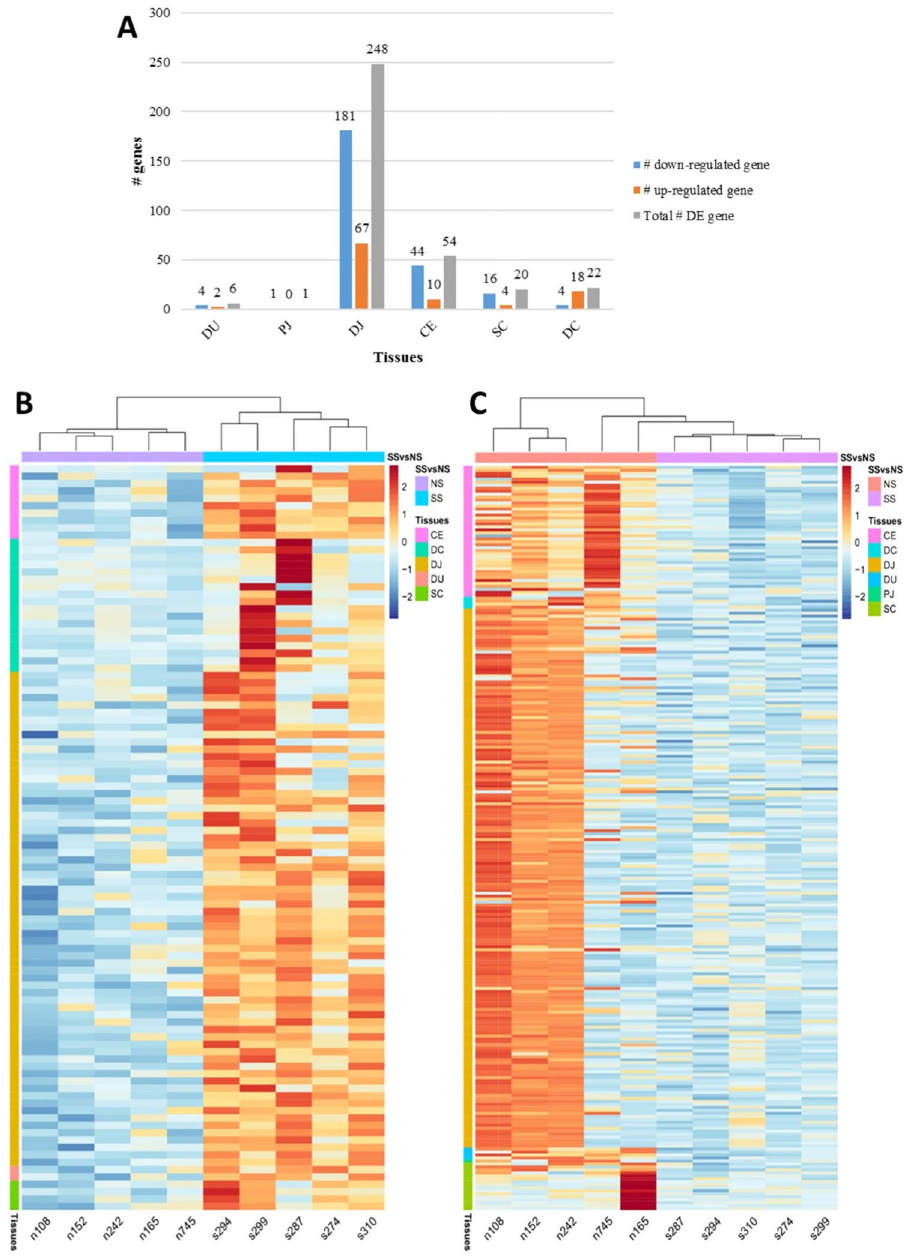
Figure 4. Differentially expressed genes between super-shedders and non-shedders. ( A ) Number of differentially expressed (DE) genes identified in intestinal regions. DE genes: FDR < 0.05, log2(fold change) <− 1 or > 1, cpm ≥ 1 in at least 50% of SS and NS. ( B ) and ( C ) are Heatmaps for log 2 (counts per million) of differentially expressed genes in all tissues: ( B ) up-regulated differentially expressed genes in super-shedders; ( C ) down-regulated differentially expressed genes in super-shedders. Scaled log2(counts per million) was indicated by red and blue colors, and red indicates higher expression level, while blue colour indicates lower expression level. The column labels indicate super-shedders and non-shedders: NS, non-shedders; SS, super- shedders. The row labels indicate the tissue where differentially expressed genes were identified. DU, duodenum; PJ, proximal jejunum; DJ, distal jejunum; CE, cecum; SC, spiral colon; DC, descending